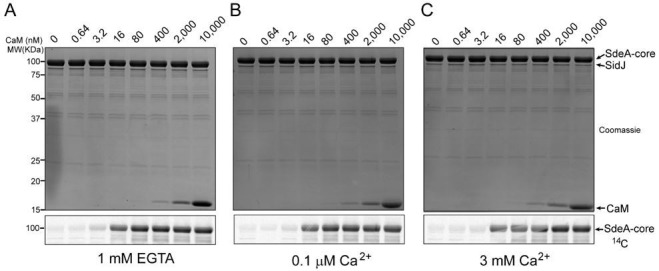
A pilot enzymatic assay of SidJ with a variable concentration of CaM and Ca2+.(A) In vitro glutamylation of SdeA with 0.5 μM SidJ and five-fold serial dilutions of CaM starting at a concentration of 10 uM. CaM concentration is labeled in nM concentrations. SidJ and CaM were preincubated separately in the presence of 1 mM EGTA and final reaction buffer also contained 1 mM EGTA. Reaction were conducted for 30 minutes and proteins were visualized by SDS-PAGE followed by Coomassie staining (top panel). The glutamylation of SdeA was detected by autoradiography (bottom panel). (B) In vitro glutamylation of SdeA as in A, with buffers containing 0.1 μM Ca2+ instead of EGTA. (C) In vitro glutamylation of SdeA as in A, with buffers containing 3 mM Ca2+ instead of EGTA.